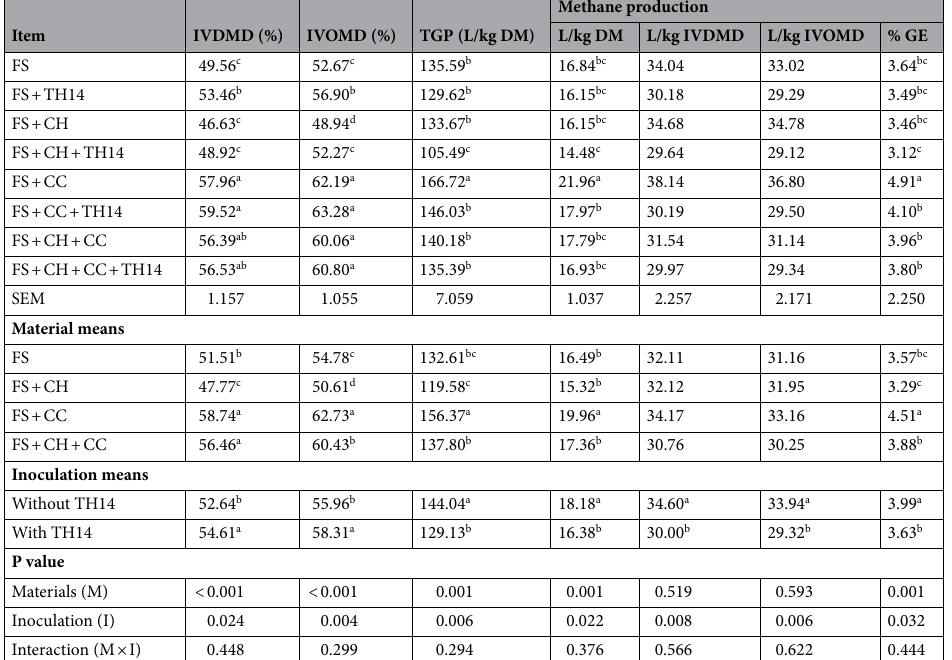
Table 5. In vitro digestibility, total gas production and methane production of the FS mixture silages after 24-h incubation. FS forage sorghum, CH Cavalcade hay, CC cassava chip, TH14 L. casei TH14 inoculant, SEM standard error of the means, IVDMD in vitro dry matter digestibility, IVOMD in vitro organic matter digestibility, TGP total gas production, GE gross energy. Means within columns with difference superscript letters differ at p <